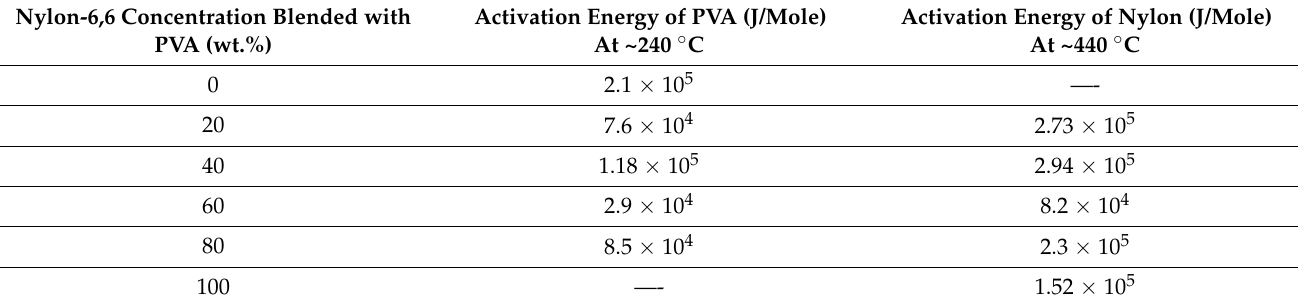
Table 1. The activation energy of the thermal decomposition E b for the investigated blends at different decomposition temperatures. Nylon-6,6 Concentration Blended